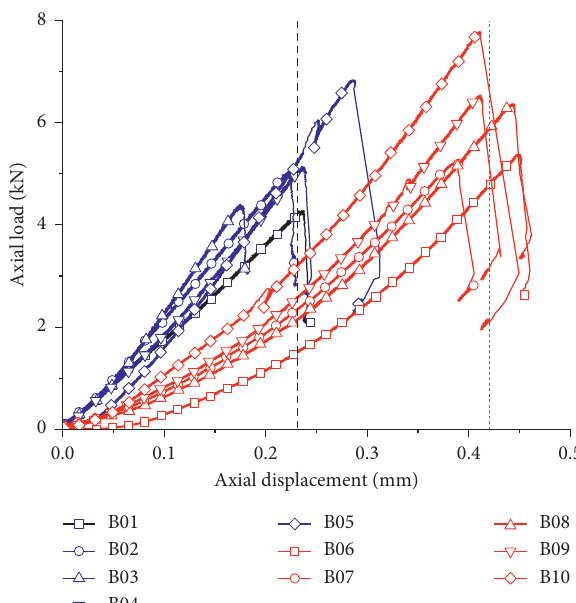
Figure 10: The load-displacement curves of Brazilian split speci- mens (the blue line is at room temperature; the red line is after treatment at 600 °